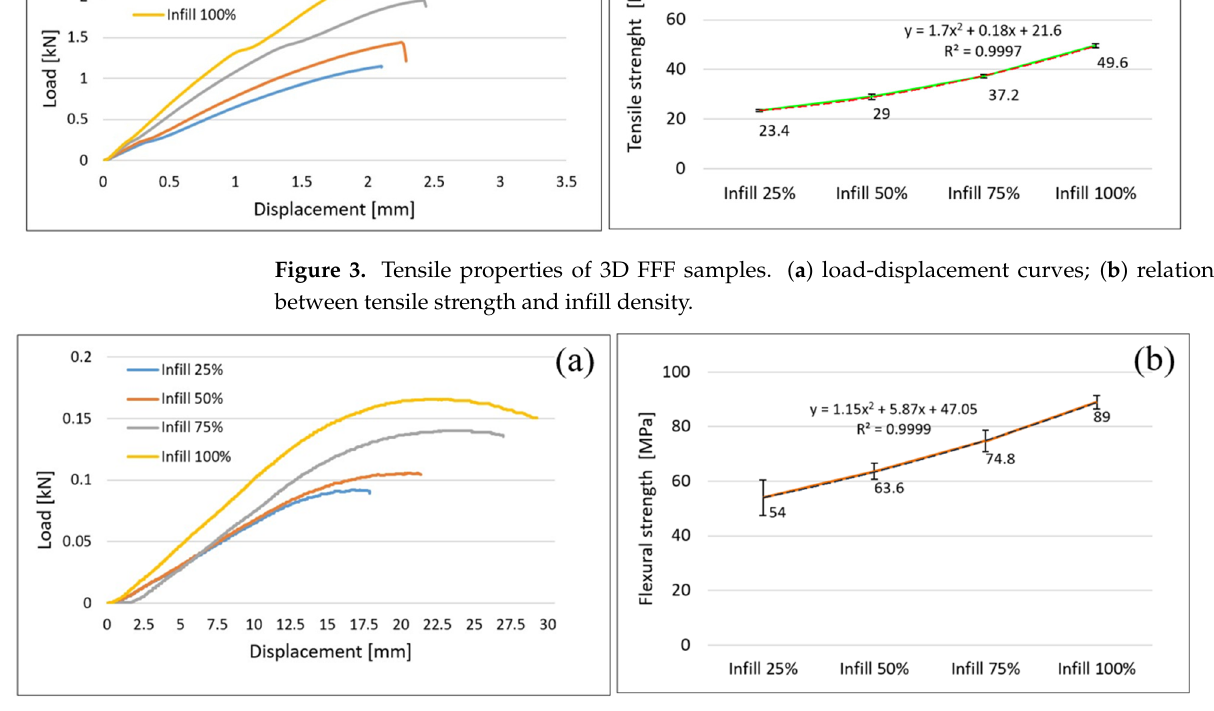
Figure 4. Three-points flexural tests; ( a ) flexural load—displacement curves; ( b ) infill density influ- ence on flexural strength.